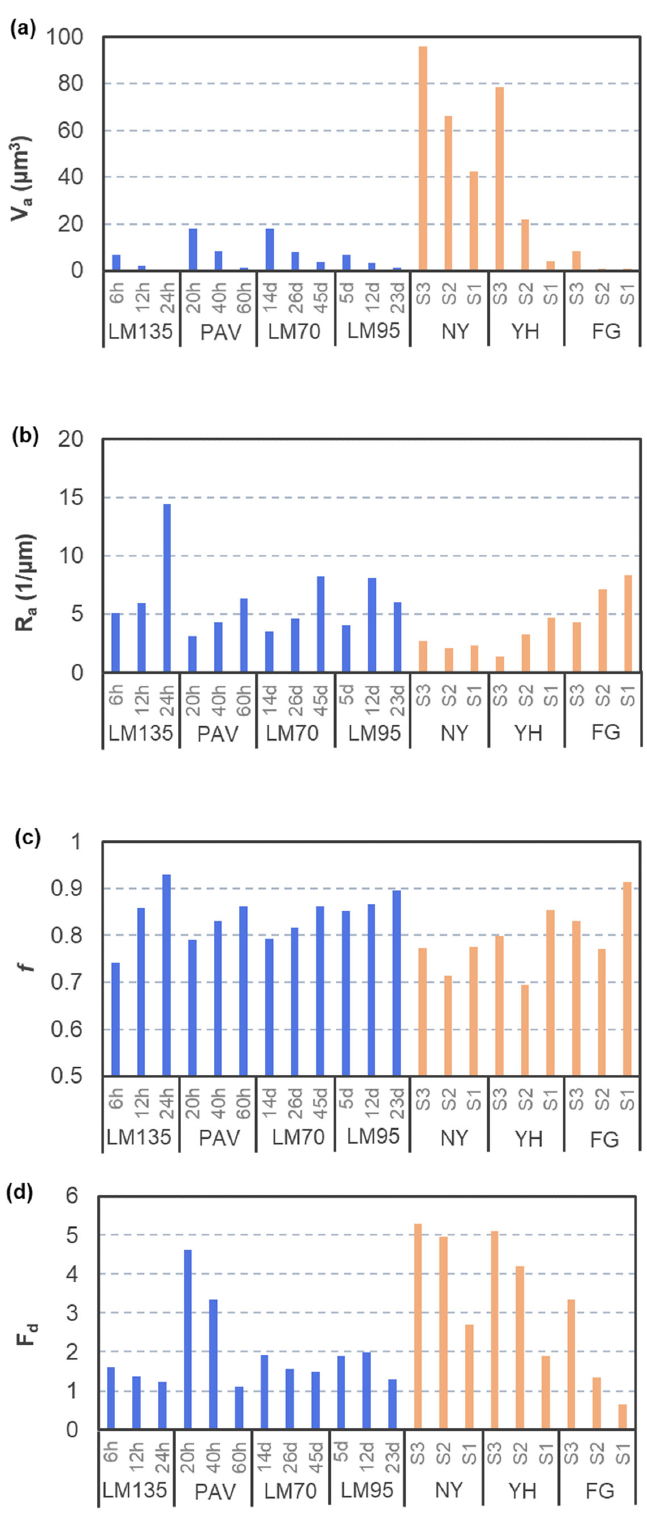
Figure 8. Three ‐ dimensional morphological parameters of SBS polymer: ( a ) 𝑉 (cid:3028) ; ( b ) 𝑅 (cid:3028) ; ( c ) 𝑓 ; and ( d ) 𝐹 (cid:3031) . ( d ) F d